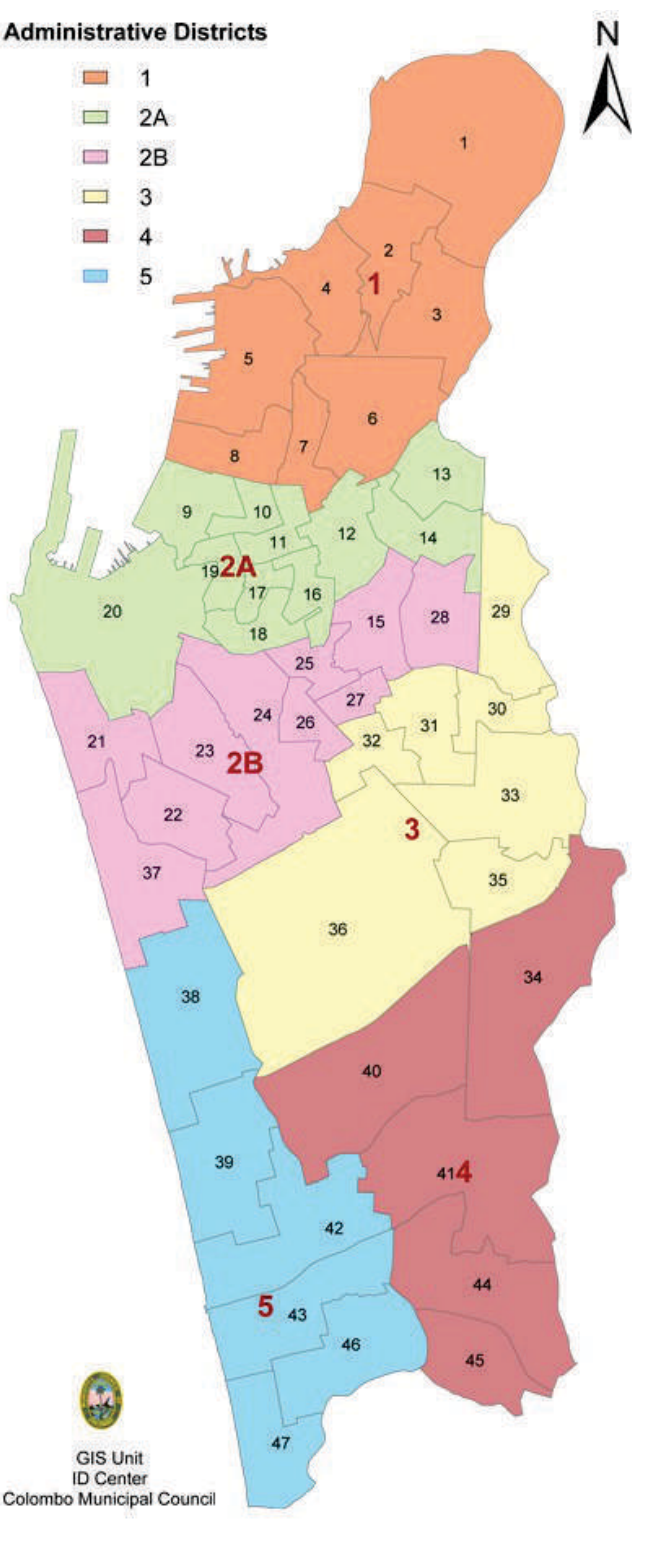
Figure 1: Administrative districts in Colombo Municipality